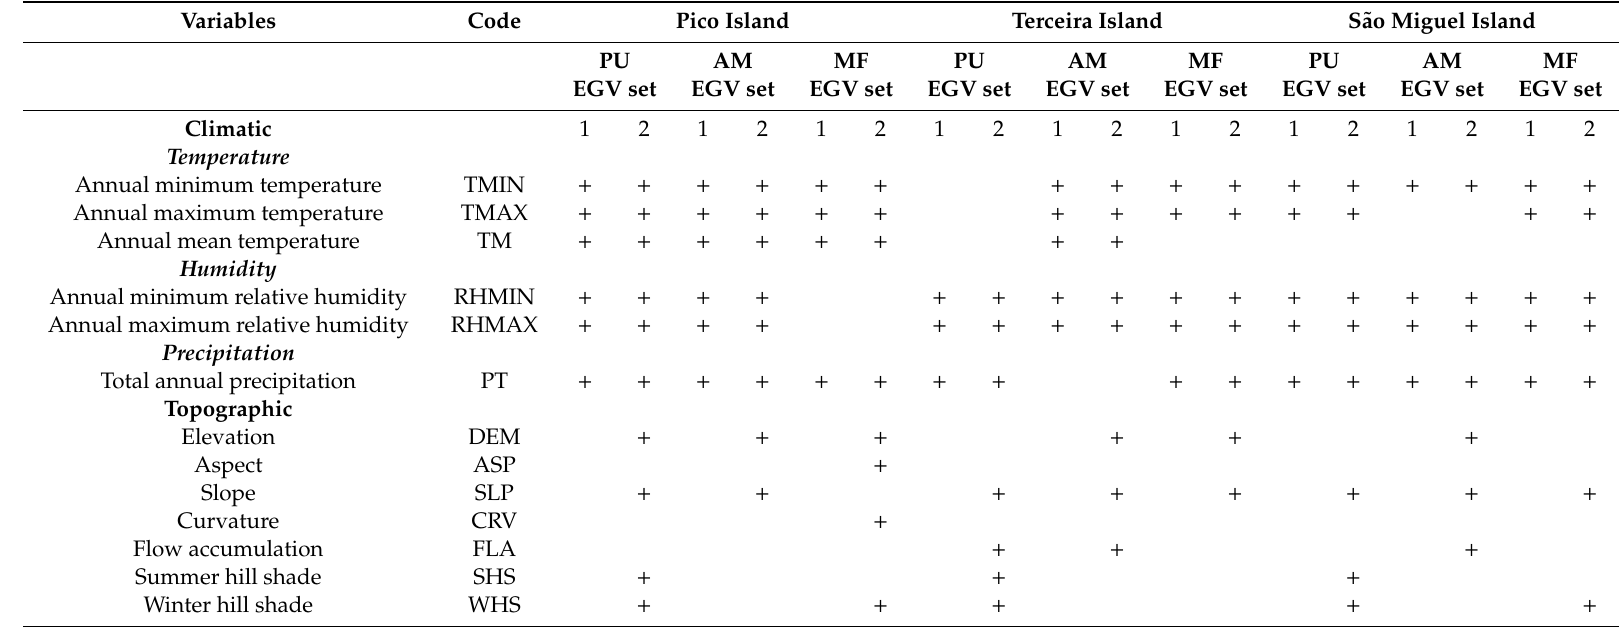
Table 4. Sets of ecogeographic variables (EGV) that produced models with highest fit in Pico, Terceira, and S ã o Miguel islands using BIOMOD 2. PU: P. undulatum ; AM: A. melanoxylon ; MF: M. faya . The modelling approach was initiated by calculating models with all the climatic or all the climatic and topographic variables described in Table 1. During model evaluation, we determined the best variable sets for each species / island combination, which are reported